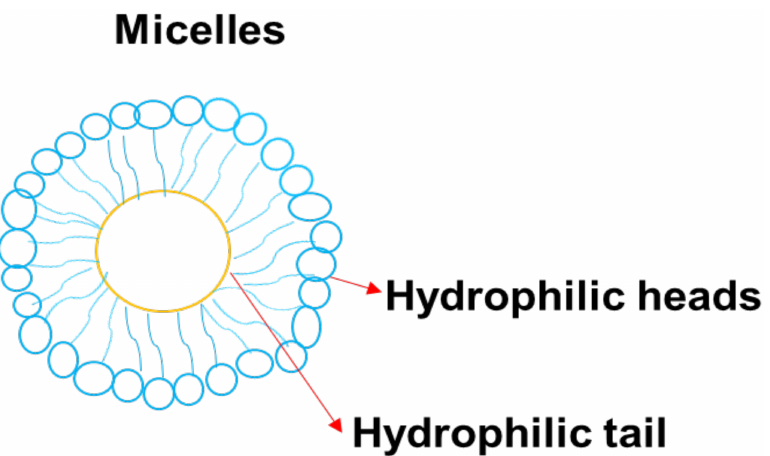
Figure 10. A schematic diagram of